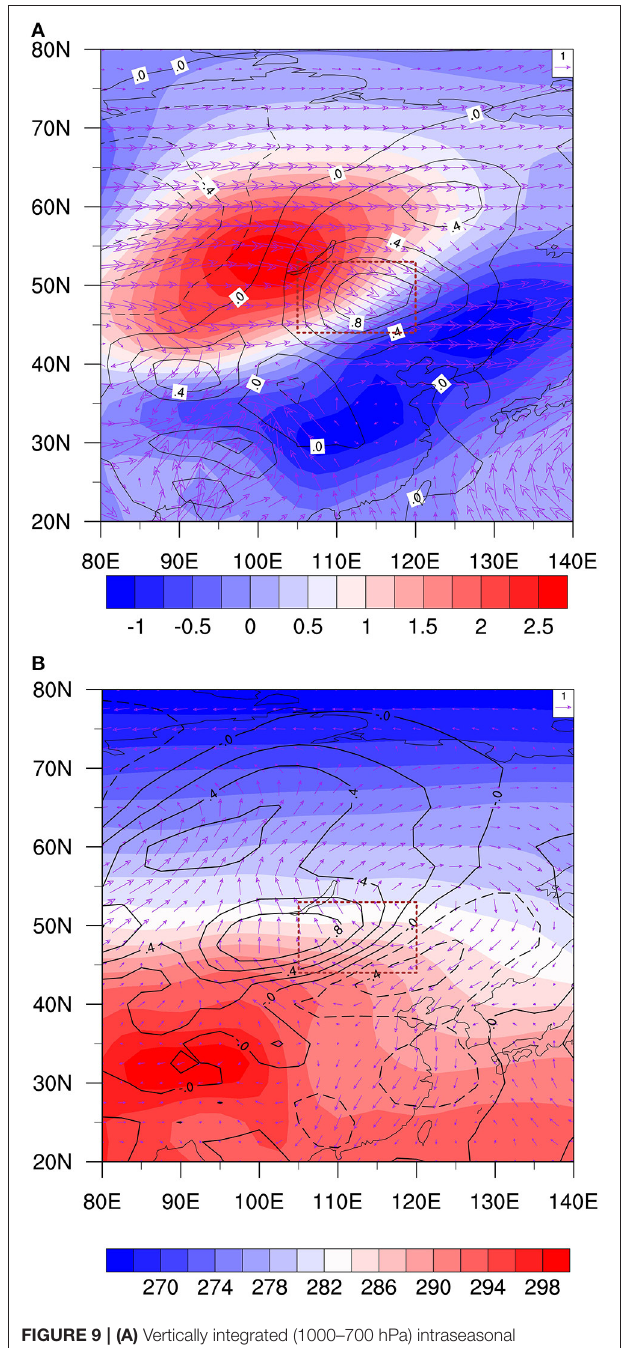
FIGURE 9 | (A) Vertically integrated (1000–700 hPa) intraseasonal temperature T ′ field (shading; unit: K), the mean wind field V (vector, unit: m s − 1 ) and the anomalous horizontal temperature advection term ( V · ∇ T ′ ) ′ (contour; unit: K s − 1 ). (B) Vertically integrated low-frequency temperature field T (shading; unit: K), the intraseasonal wind field V ′ (vector, unit: m s − 1 ) and the anomalous temperature advection term − V ′ · ∇ T) ′ (contour; unit: K s − 1 ) for day − 3 composite. The red box is same as in Figure 8A